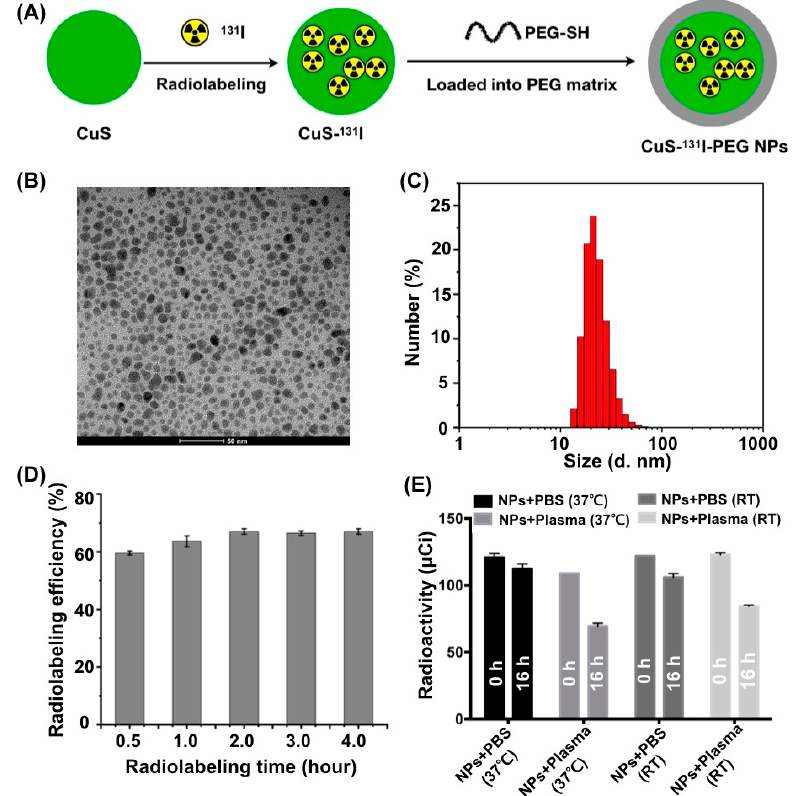
Figure 1. Preparation and physicochemical properties of CuS- 131 I-PEG nanotheranostics. ( A ) Schematic illustration to show the preparation of CuS- 131 I-PEG nanotheranostics. ( B ) TEM image of nanotheranostics. ( C ) Hydrodynamic size distribution of nanotheranostics measured by dynamic light scattering. ( D ) Radiolabeling efficiency of 131 I at different time points. ( D ) Radiolabeling efficiency of 131 I in CuS- 131 I-PEG nanotheranostics for 4 h. ( E ) Radiolabeling stability of CuS- 131 I-PEG nanotheranostics incubated with fresh mouse plasma and PBS at 37 °C and room temperature (RT) for 16 h, respectively.